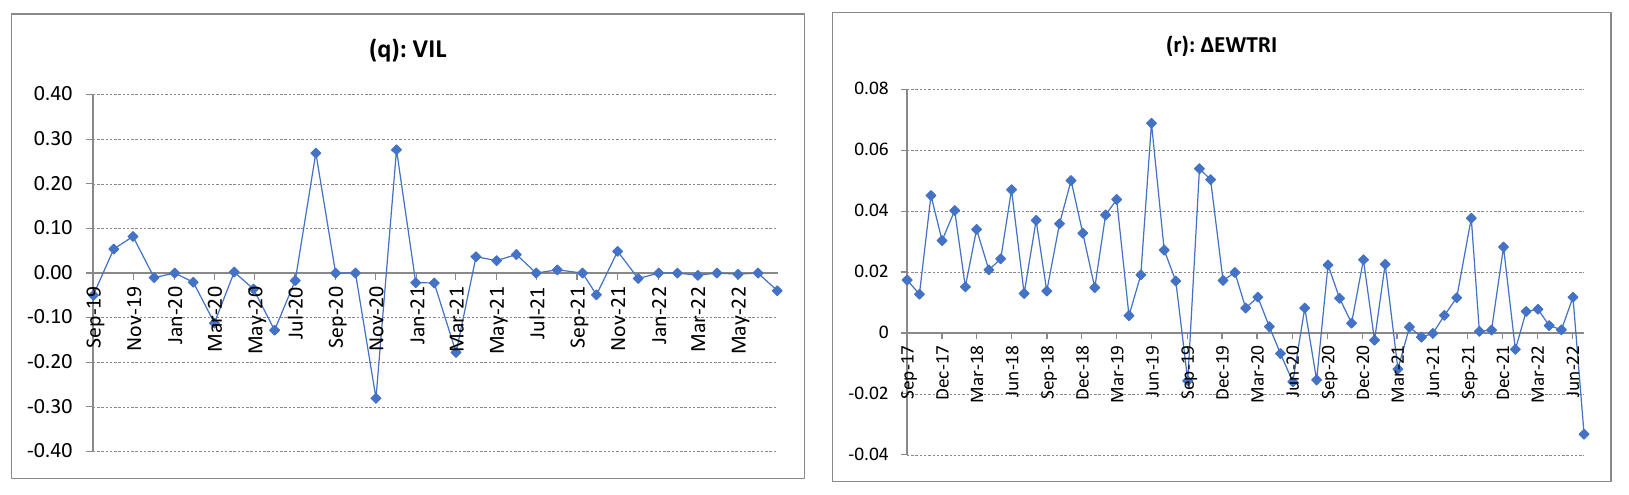
Figure 1. Changes in stock prices and EWTRI. Table 3. ( a ) 1/N and mean-variance portfolios. ( b ) Utility maximizing portfolio. ( c ) Semi-variance portfolio. ( d ) Turbulence adjusted portfolio.